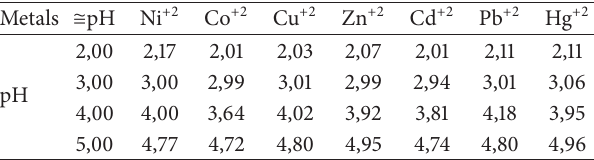
Table 2: Extraction of metal cations with L1 (%).